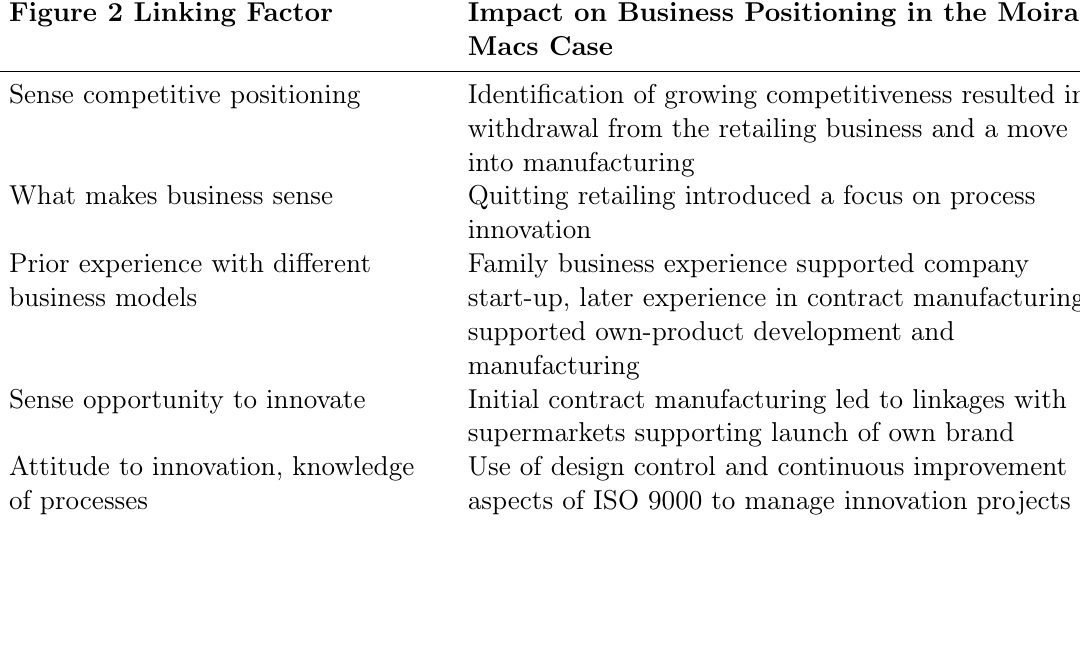
Table 6 . Examples of linking factor influence Figure 2 Linking